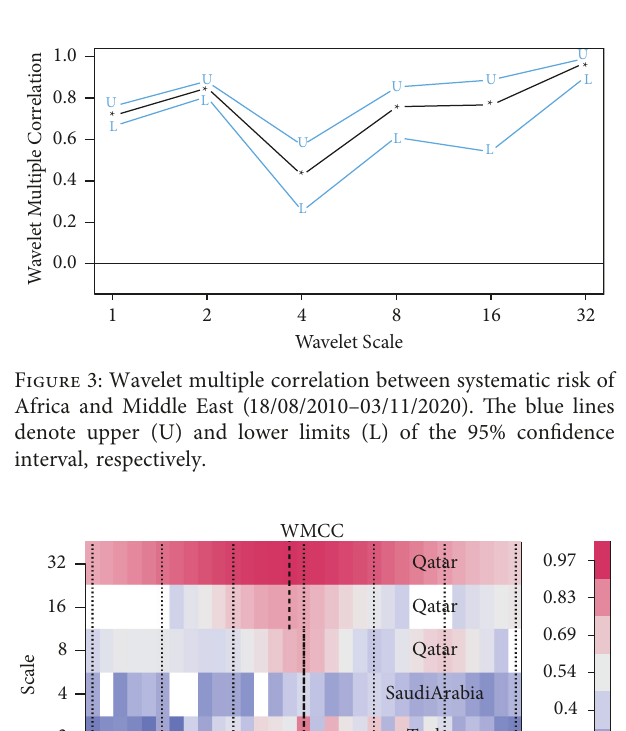
Figure 2: Wavelet bivariate correlations matrix (18/08/2010–03/11/2020). The codes for the variables are Egypt (C1), South Africa (C2), Qatar (C3), Saudi Arabia (C4), Turkey (C5), and UAE (C6).